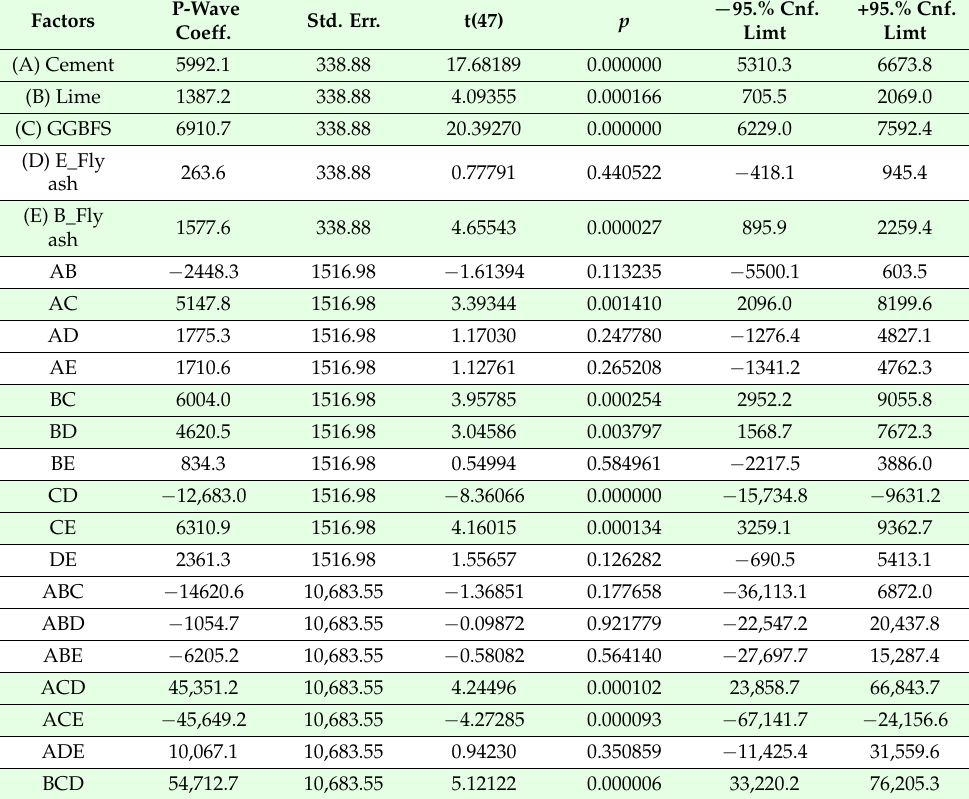
Table 7. The effects from various binders on soil stabilisation on day 90th of curing time, measured by P-wave